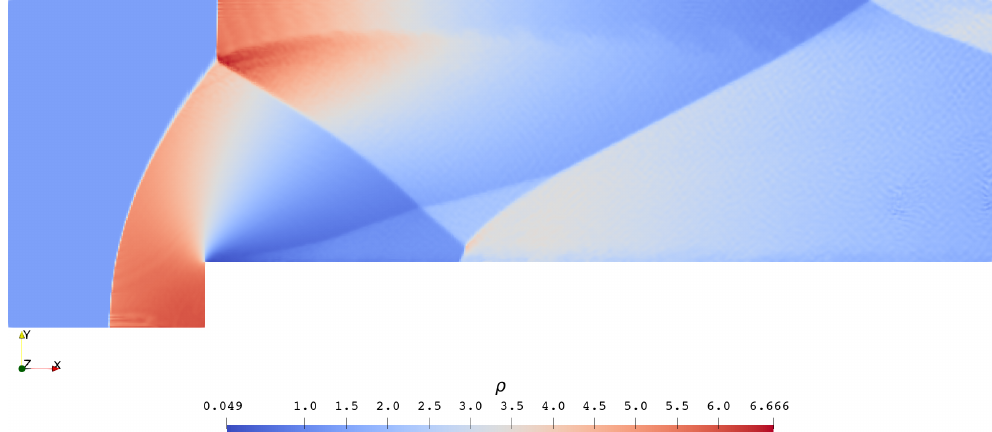
Figure 18. Third-order solution of Problem 4 at t = 3.2 on an h = 1/200 mesh.